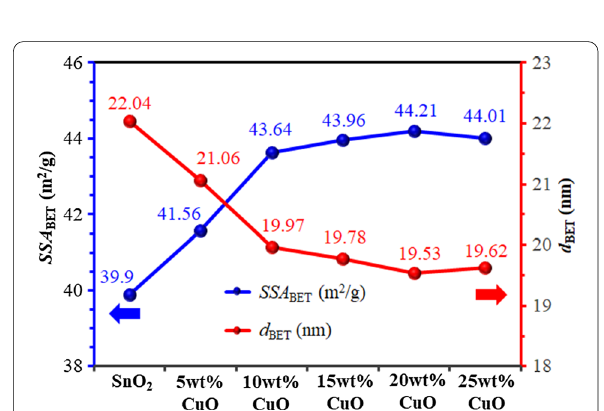
Fig. 3 BET specific surface area (SSA BET ) and particle diameter ( d BET ) of SnO 2 and 5–25 wt% CuO/SnO 2